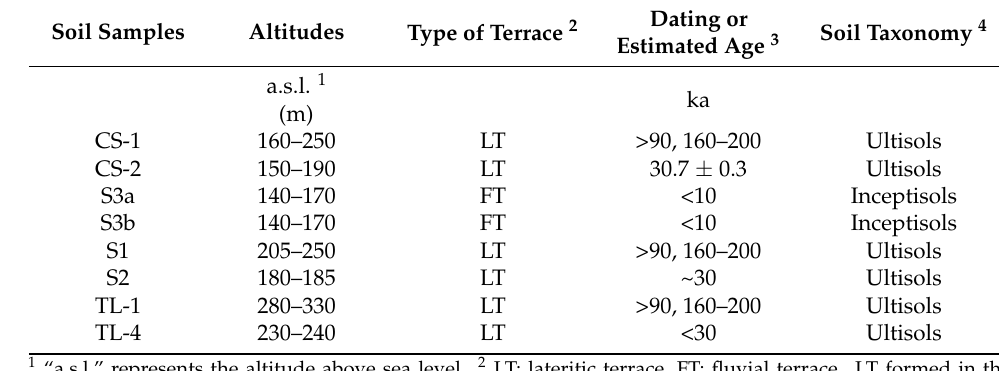
Table 1. The soil samples and geomorphic features of the terraces in the mid-reaches of the Zoushui